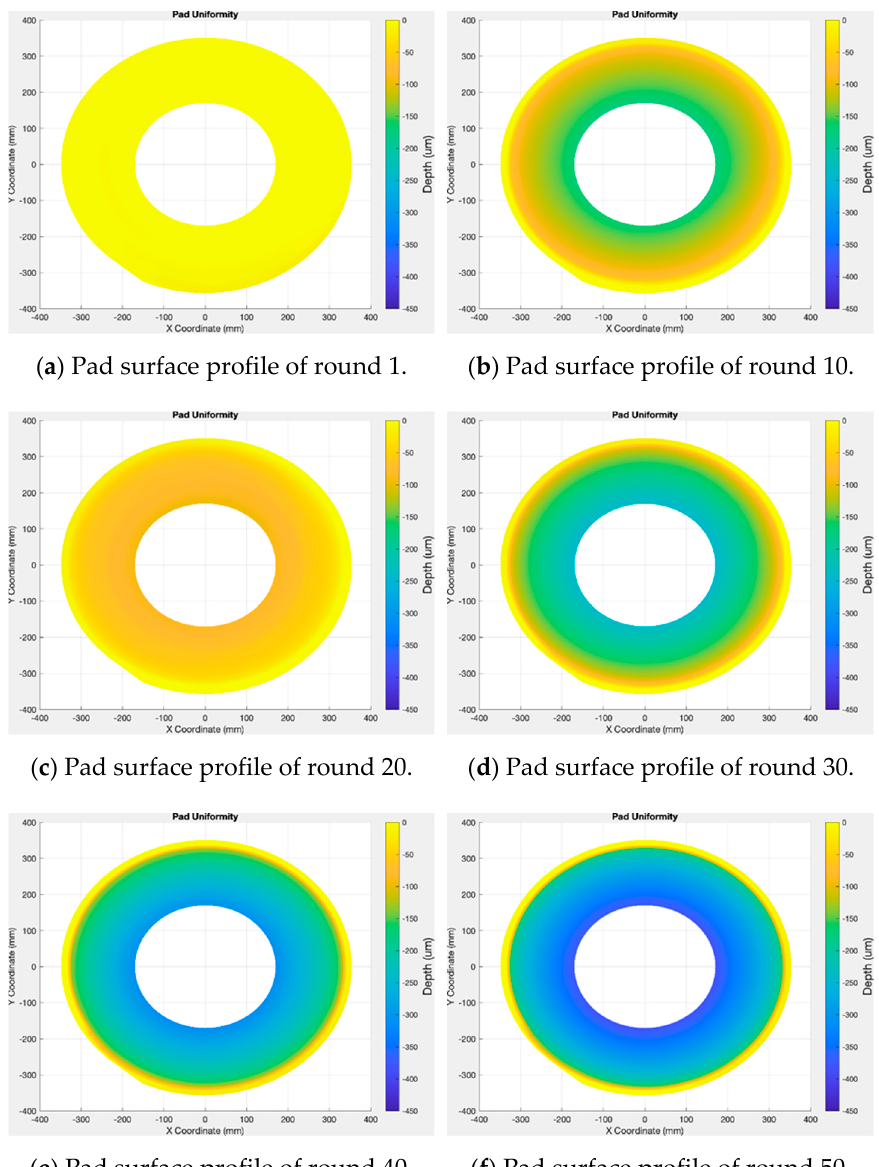
Figure 10. Re − mapped pad surface profile from round 1 to round 50.